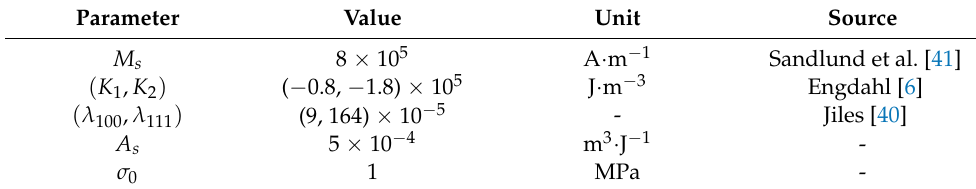
Table 1. Modelling parameters for the multiscale model.